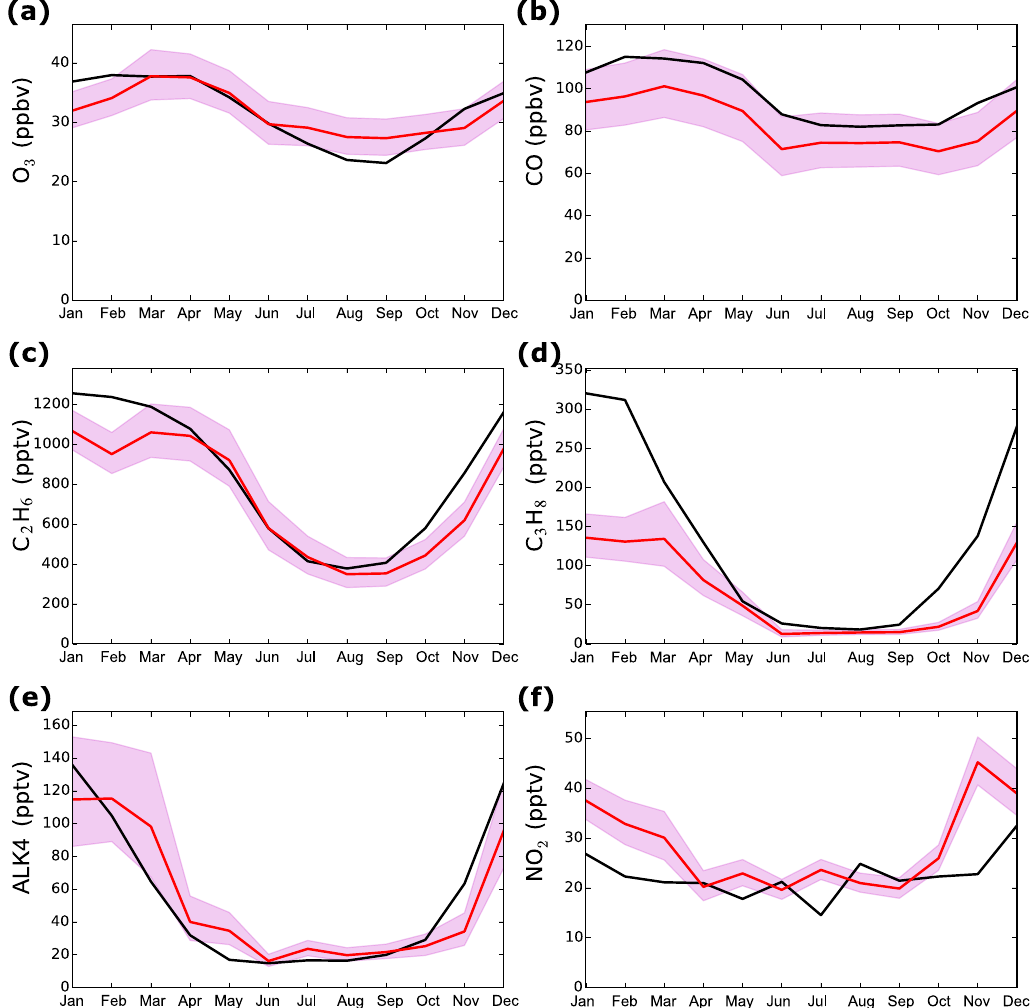
Figure 12. Impact on model/measurement comparisons: modelled (red) and measured (black) annual cycle in monthly mean O 3 , CO, C 2 H 6 , C 3 H 8 , ALK4 ( ≥ C4 alkanes) and NO 2 mixing ratios at Cabo Verde (Carpenter et al., 2011). Shaded area represents the 1 σ uncertainty from the 60 reactions added together in